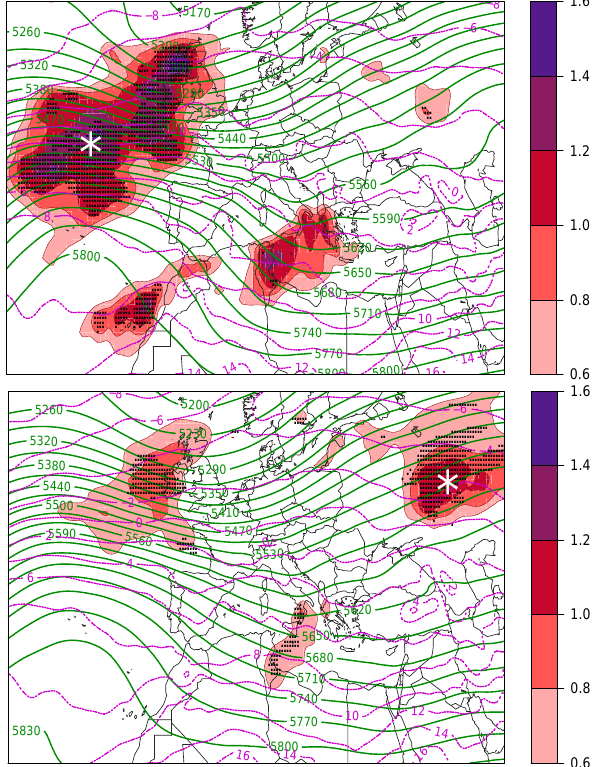
Fig. 4. Mean ensemble sensitivity field (mb,shaded) for an Adriatic Sea cluster at t − 48h for the pruned version (30 members, upper panel) and for the non-pruned version (51 members, lower panel). Geopotential height field at 500hPa (gpm, solid lines) and temper- ature field at 850hPa ( ◦ C, dashed lines) averaged over all cluster’s members. Dots indicate gridpoints where an outstanding percentage of computed trends are above the 95% significance level. The cen- ter of the perturbation of the corresponding numerical experiment is labelled by